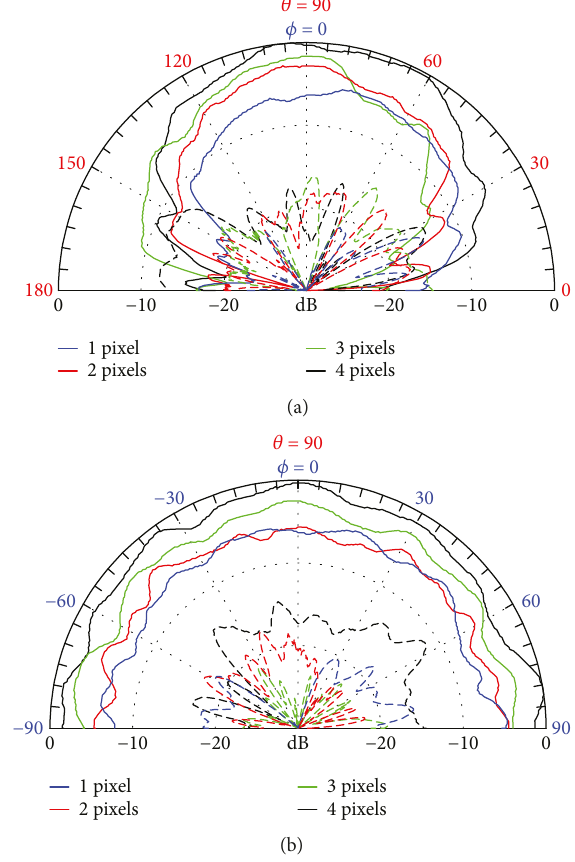
Figure 4: Measured copolarized (solid) and cross-polarized (dashed) radiation patterns in the (a) E-plane and (b)